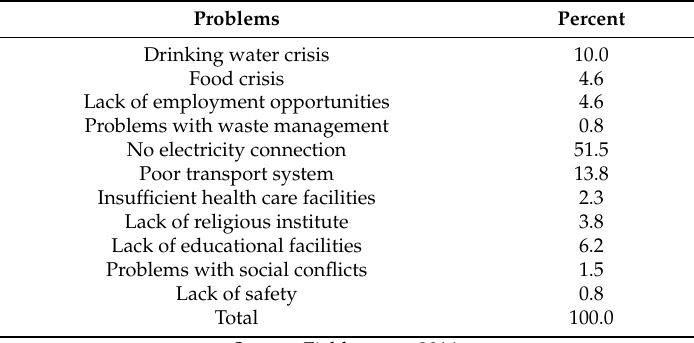
Table 10. Problems of the GG reported by